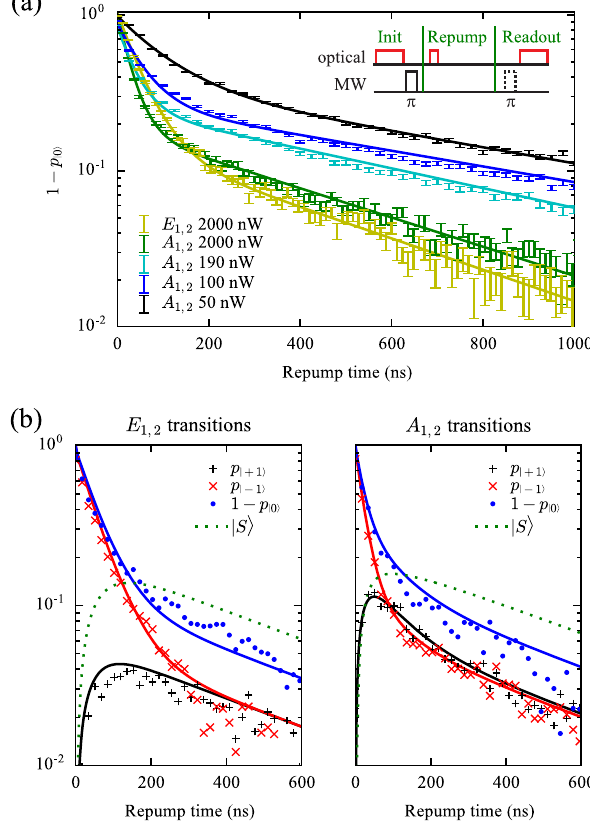
FIG. 2. NVelectronic spin initialization. (a) Probability that the electronic spin is pumped to j 0 i as a function of the repump laser pulse duration when the spin is initially prepared in j − 1 i . The inset shows the used pulse sequence. We observe a double- exponential decay (solid fit curves), with a time scale and relative amplitude that depends on the used “ reset ” transition. Reduced laser power leads to slower initialization time scales. (b) Proba- bility that the NV is found in state j 0 i , j þ 1 i , and j − 1 i for 2000-nW repump power in the j E 1 ; 2 i (left) or j A 1 ; 2 i (right) configuration. The solid lines are calculated using a rate equation model described in the text. For long repumping time, the calculated population in the metastable singlet states (green dotted curve) dominates the repumping